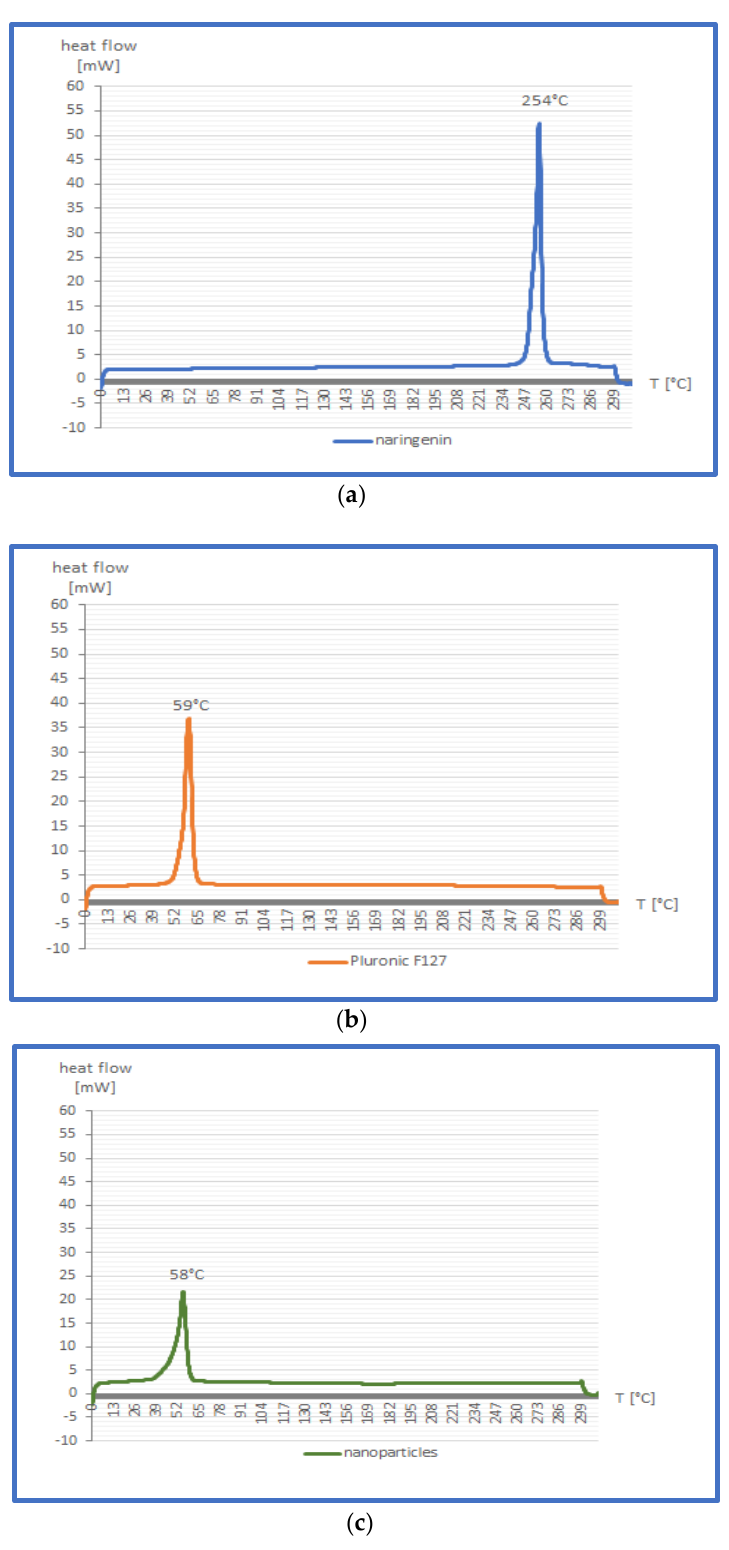
Figure 4. Results of DSC analysis of crude naringenin ( a ), Pluronic F127 ( b ) and naringenin–Pluronic F127 1:10 nanoparticles ( c ).